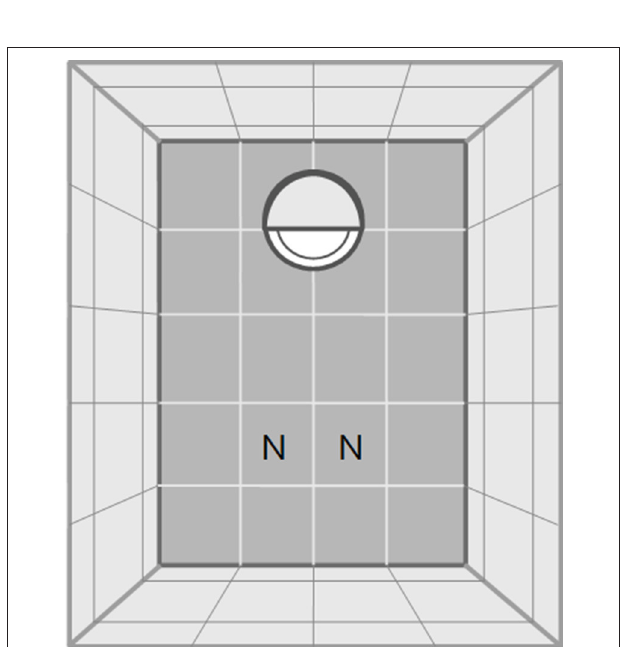
FIGURE 1 | Schematic drawing of the test arena for both, the open field and the novel object test. Dark gray fields indicate ground, light gray fields indicate walls. In one end of the arena a white opaque plastic cap is shown which functioned as start point. The cap was half-covered with gray plastic foil to generate shelter for the spiders. The letters “N” indicate the two possible positions in which the novel object was introduced at the beginning of the novel object test. The drawing is not to